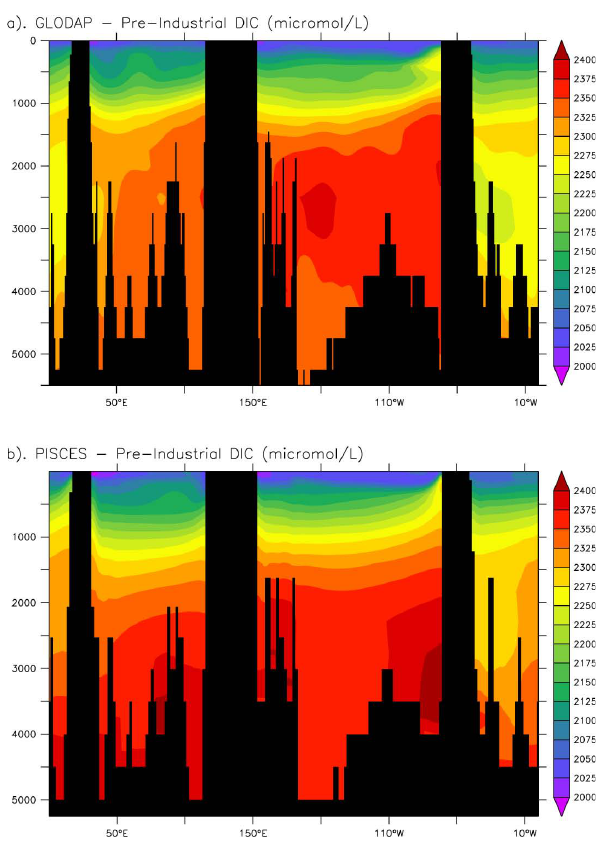
Fig. A1. Upper panel: GLODAP DIC section at 30 ◦ S. Lower panel: PISCES DIC section at 30 ◦